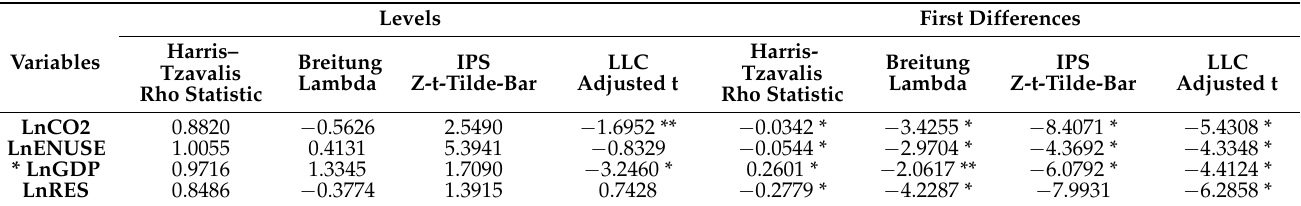
Table 3. Results of the first generation panel unit root tests.